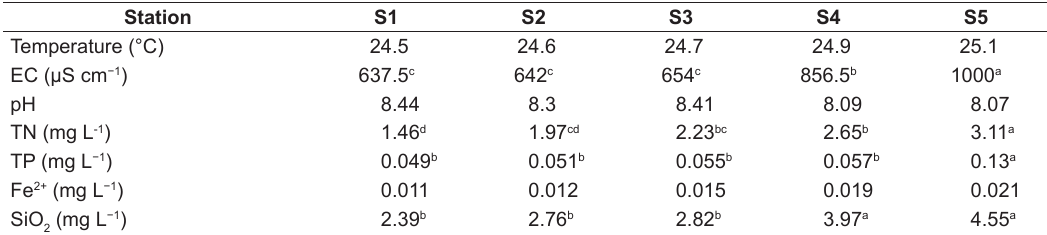
Figure 2. Light micrograph of Pleurosira laevis Compère from Masuleh River. (R= Rimoportulae; O= Ocelli). Table 1. The mean values of physicochemical parameters measured at 5 sampling station.